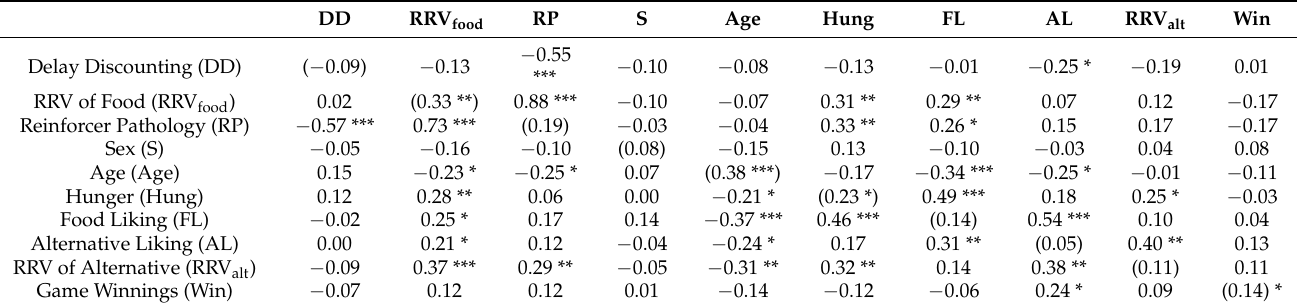
Table 2. Correlations on Control